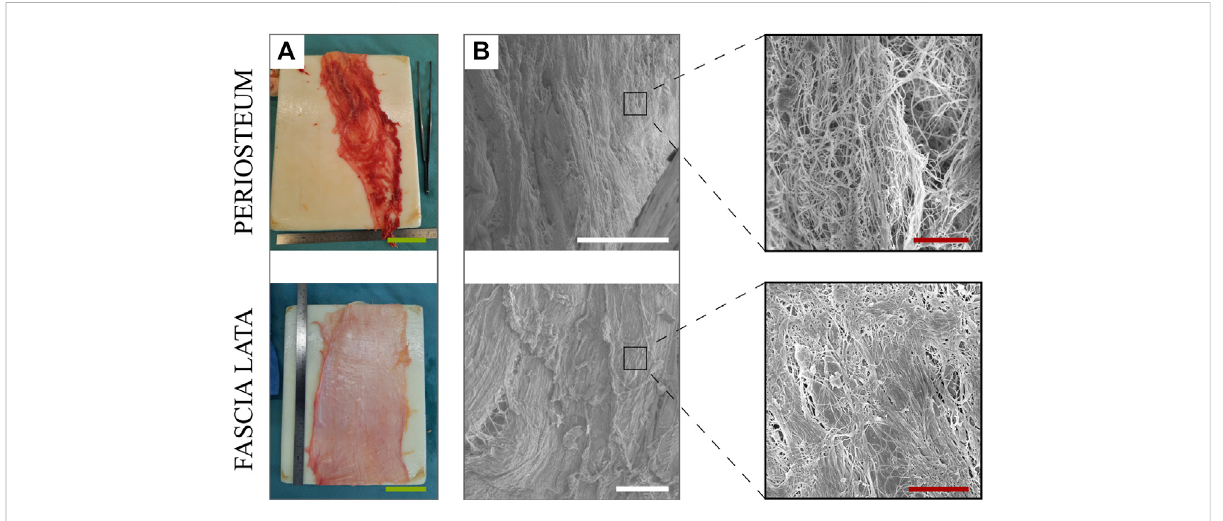
FIGURE 1 Macrostructure (A) and microstructure (B) of the periosteum (top) and fascia lata (bottom) (including zoom in), visualized under electron microscopy. Green scale bars: 5 cm. White scale bars: 100 µm. Red scale bars: 5